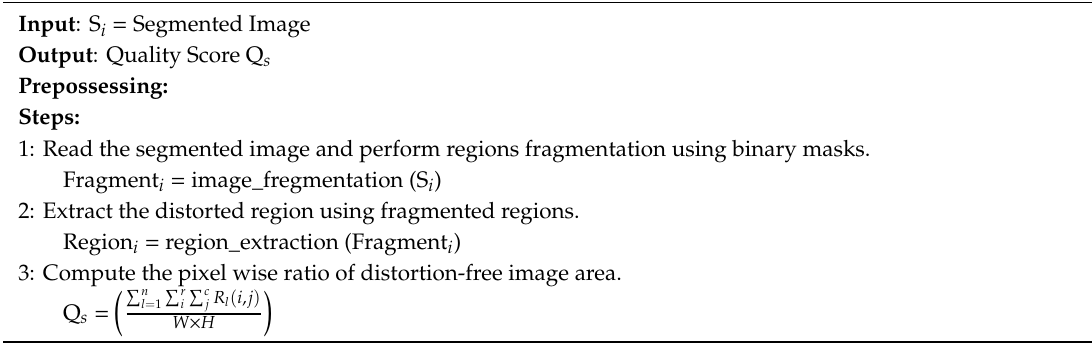
Algorithm 1: Quality Estimation of Stitched Image